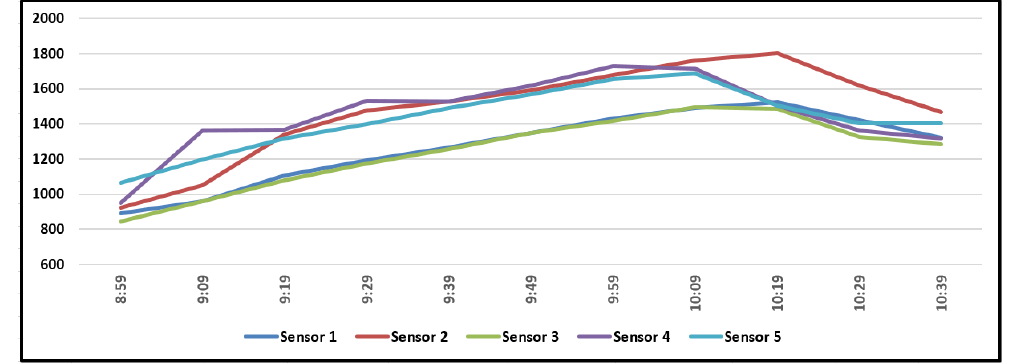
Figure 8. CO 2 concentration in the yurt between 9.00 am and 11.00 am on 9th of February 2021 with three users.